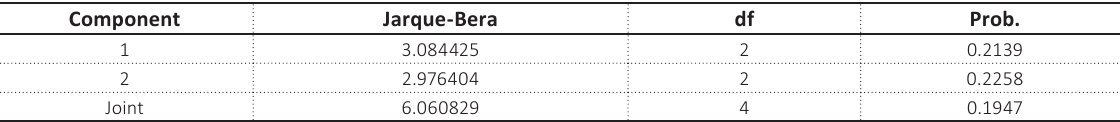
Table 8. VAR residual normality tests